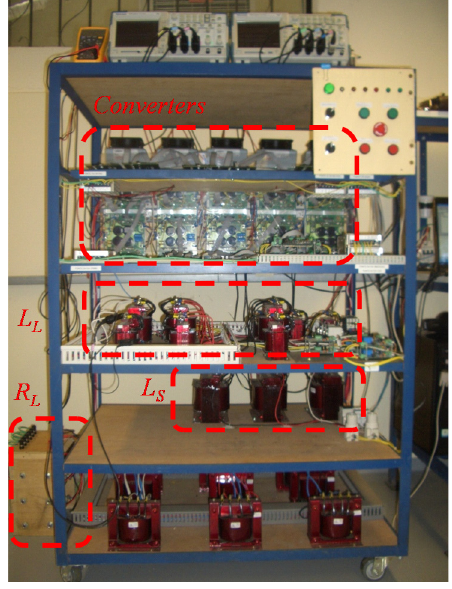
Figure 8. 2.0 kVA laboratorial